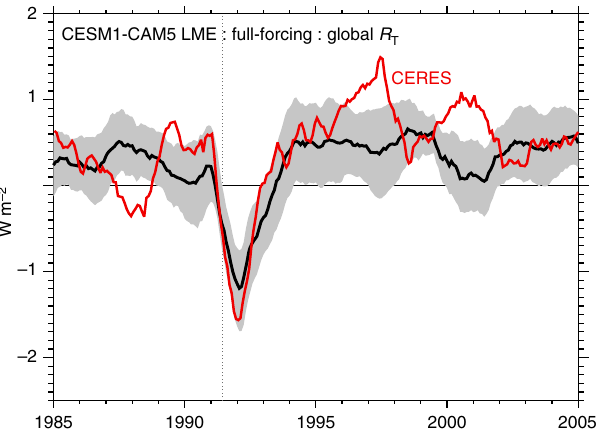
Fig. 8 Validation of the LME-simulated TOA fl ux response to the 1991 Pinatubo eruption. LME mean global TOA net fl ux ( R T ) vs. CERES (red) from 1985 to 2005 and spanning the 1991 eruption of Mt. Pinatubo. A 12- month running mean is applied to simulated and observed fl uxes prior to plotting and computing ensemble spread. Gray shading indicates the standard deviation range in the